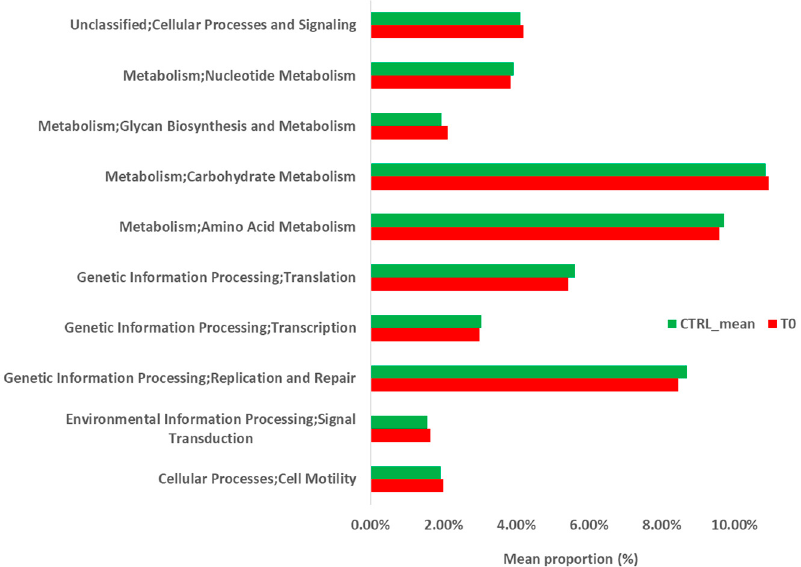
Figure 8. Predicted functional pathways (KEGG Level II) of the gut microbiota during infection (T 0 ) with S. stercolaris .